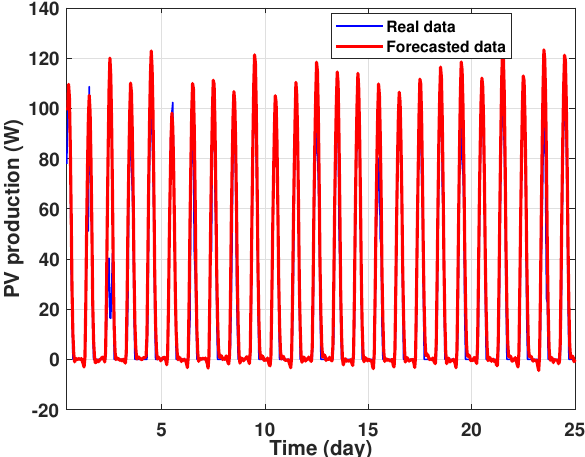
Figure 28. Zoom version of the PV panel power forecasting over 25